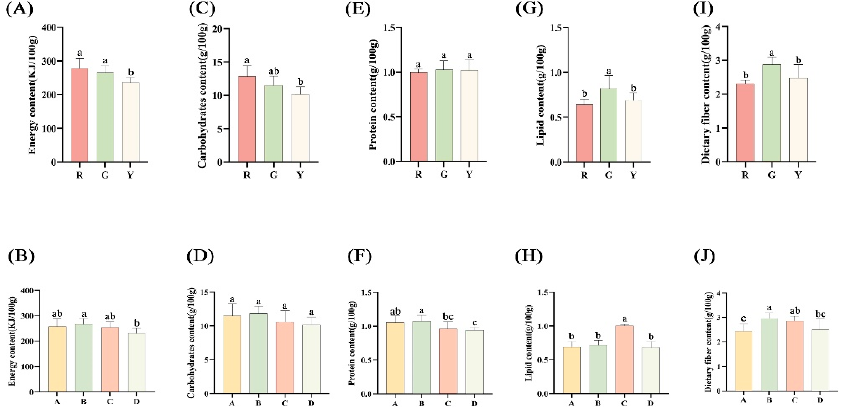
Figure 2. The contents of energy, carbohydrates, protein, lipid and dietary fiber. ( A ) The contents of energy in different flesh color. ( B ) The contents of energy in species. ( C ) The contents of carbohydrates in different flesh color. ( D ) The contents of carbohydrates in species. ( E ) The contents of protein in different flesh color. ( F ) The contents of protein in species. ( G ) The contents of lipid in different flesh color. ( H ) The contents of lipid in species. ( I ) The contents of dietary fiber in different flesh color. ( J ) The contents of dietary fiber in species). ‘R’—red-fleshed kiwifruit. ‘G’—green-fleshed kiwifruit. ‘Y’—yellow-fleshed kiwifruit. ‘A’— A. chinensis . ‘B’— A. chinensis var. deliciosa . ‘C’— A. eriantha . ‘D’— A. eriantha × A. chinensis . Values are means ± SD of three individual biological reproductions. Different lowercase letters indicated statistically significant differences (Duncan’s multiple range test, p < 0.05) among different kiwifruit